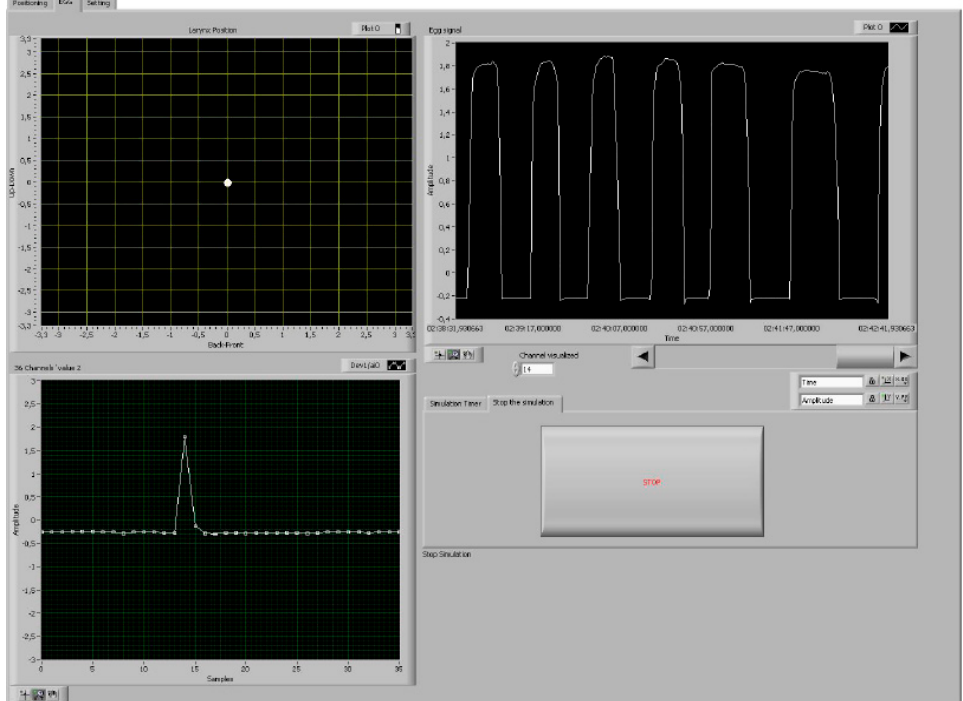
Figure 4. Labview Main Panel for acquiring data: EGG page.